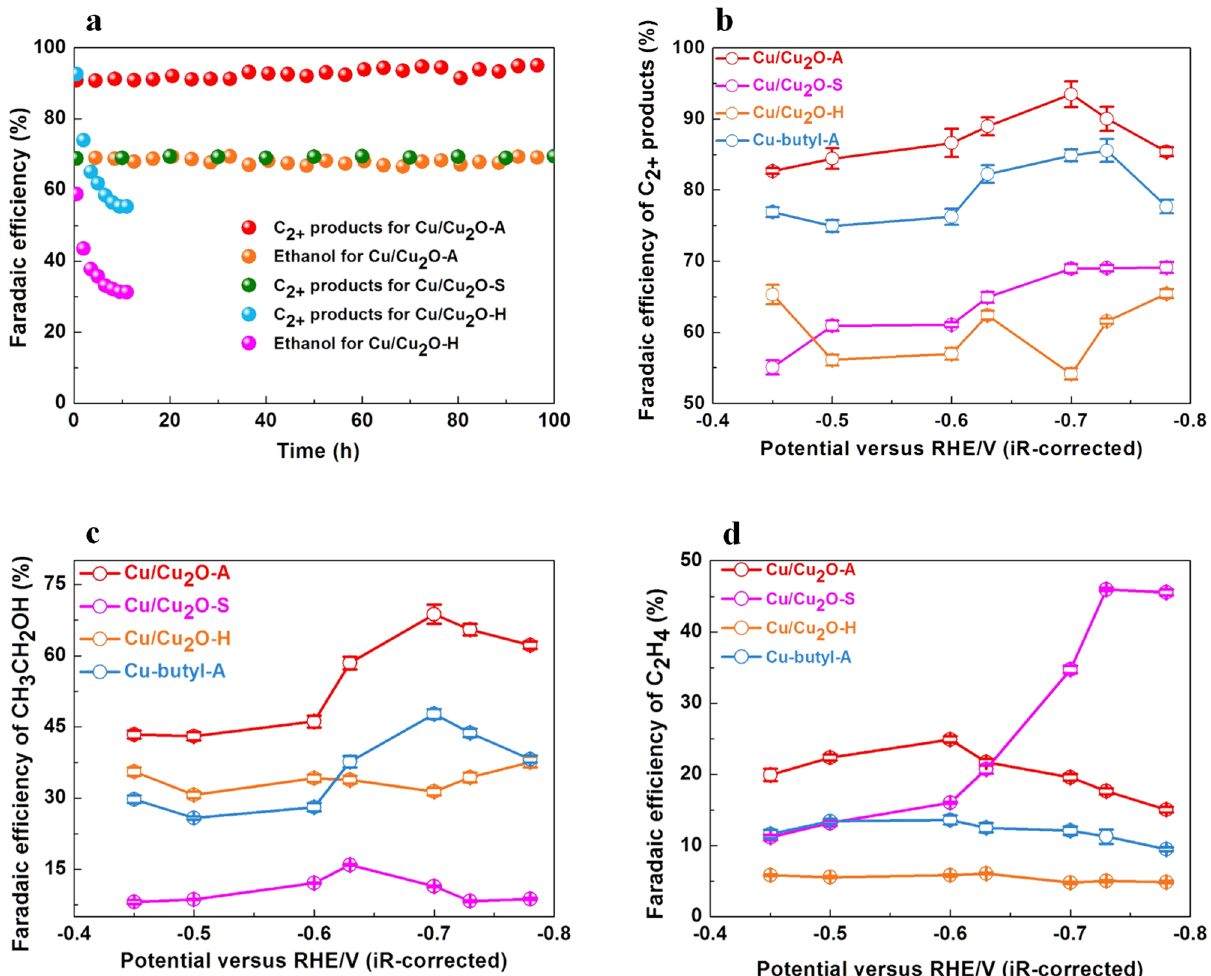
Fig.5|Faradaicef fi ciencyofvariousproductsforCu-basedcatalysts.a Stability testofelectrolysisin2.0MKOHforCu/Cu 2 O-A,Cu/Cu 2 O-SandCu/Cu 2 O-H. b FEof C 2+ products, c FEofethanol,and d FEofethylene forCOelectroreduction on Cu/